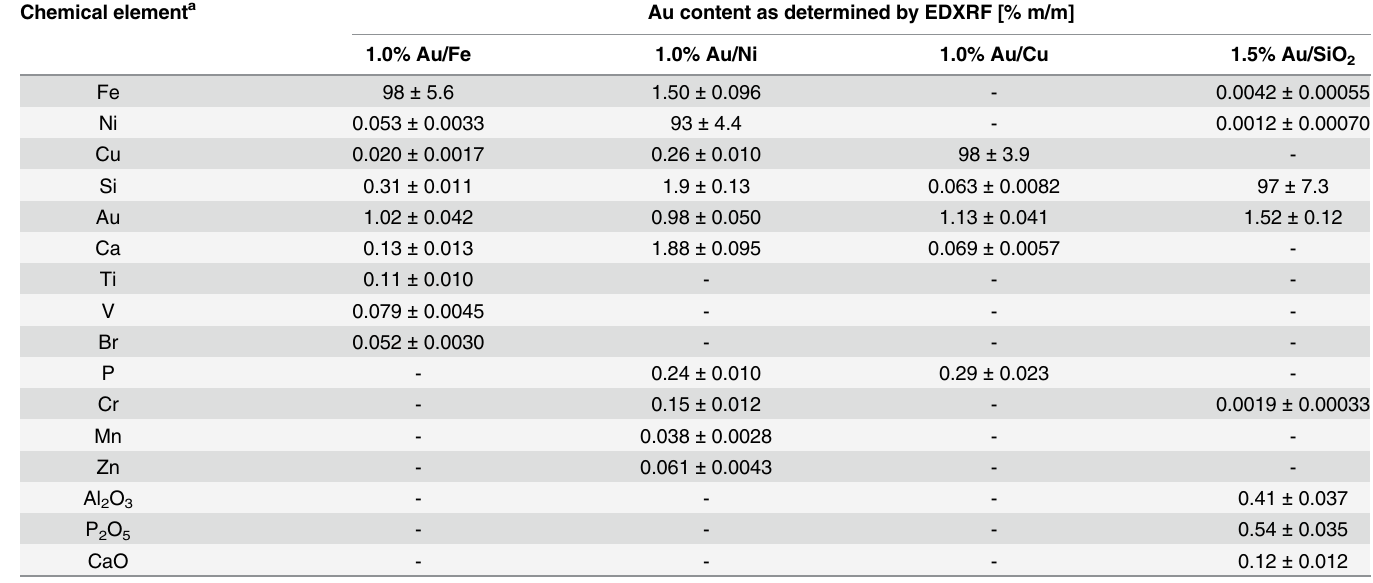
Table 2. Au NPs content as determined by EDXRF analysis over SiO 2- and Cu-, Ni- and Fe-carriers. Chemical element a